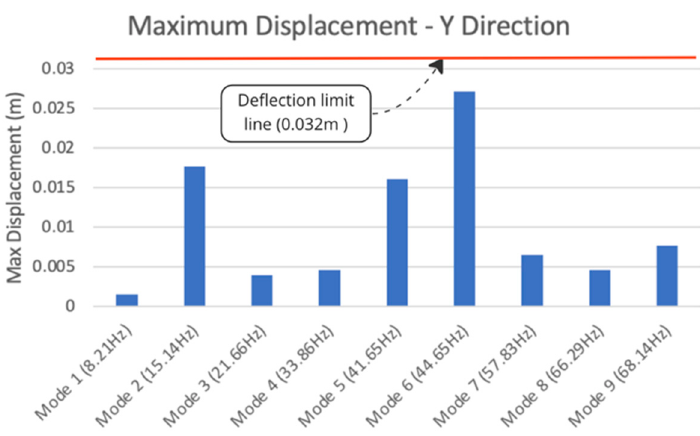
Figure 25. Deflection limit and the maximum vertical deflection for each frequency mode.